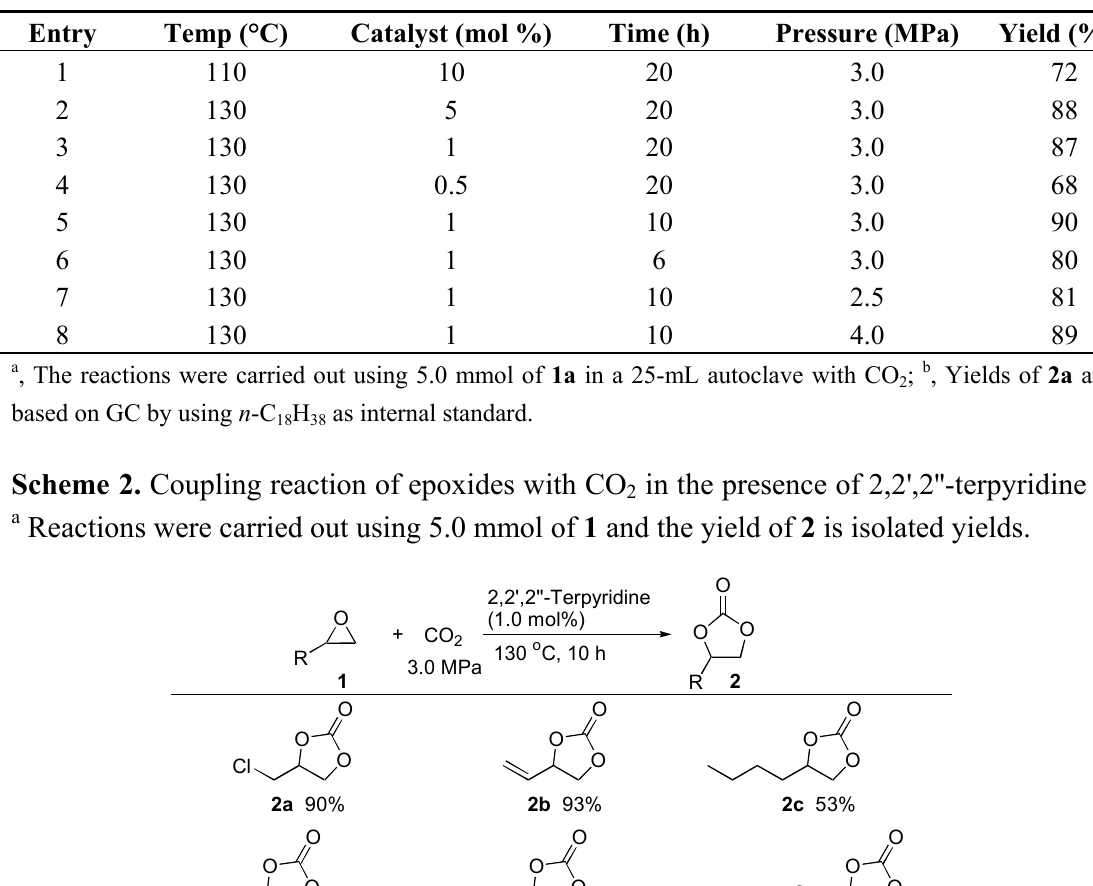
Table 2. Effect of reaction conditions on the formation of 4-cholromethyl-[1,3]dioxolan- 2-one ( 2a ) using 2,2',2''-terpyridine as catalyst a